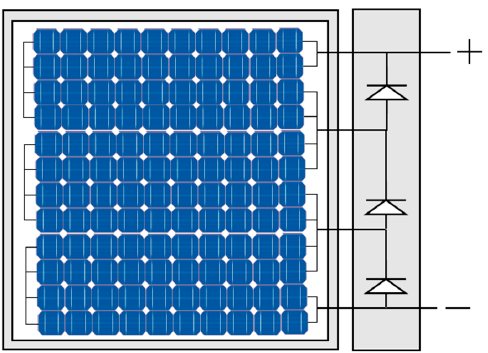
Figure 13. Half-cell module BP diode connections.